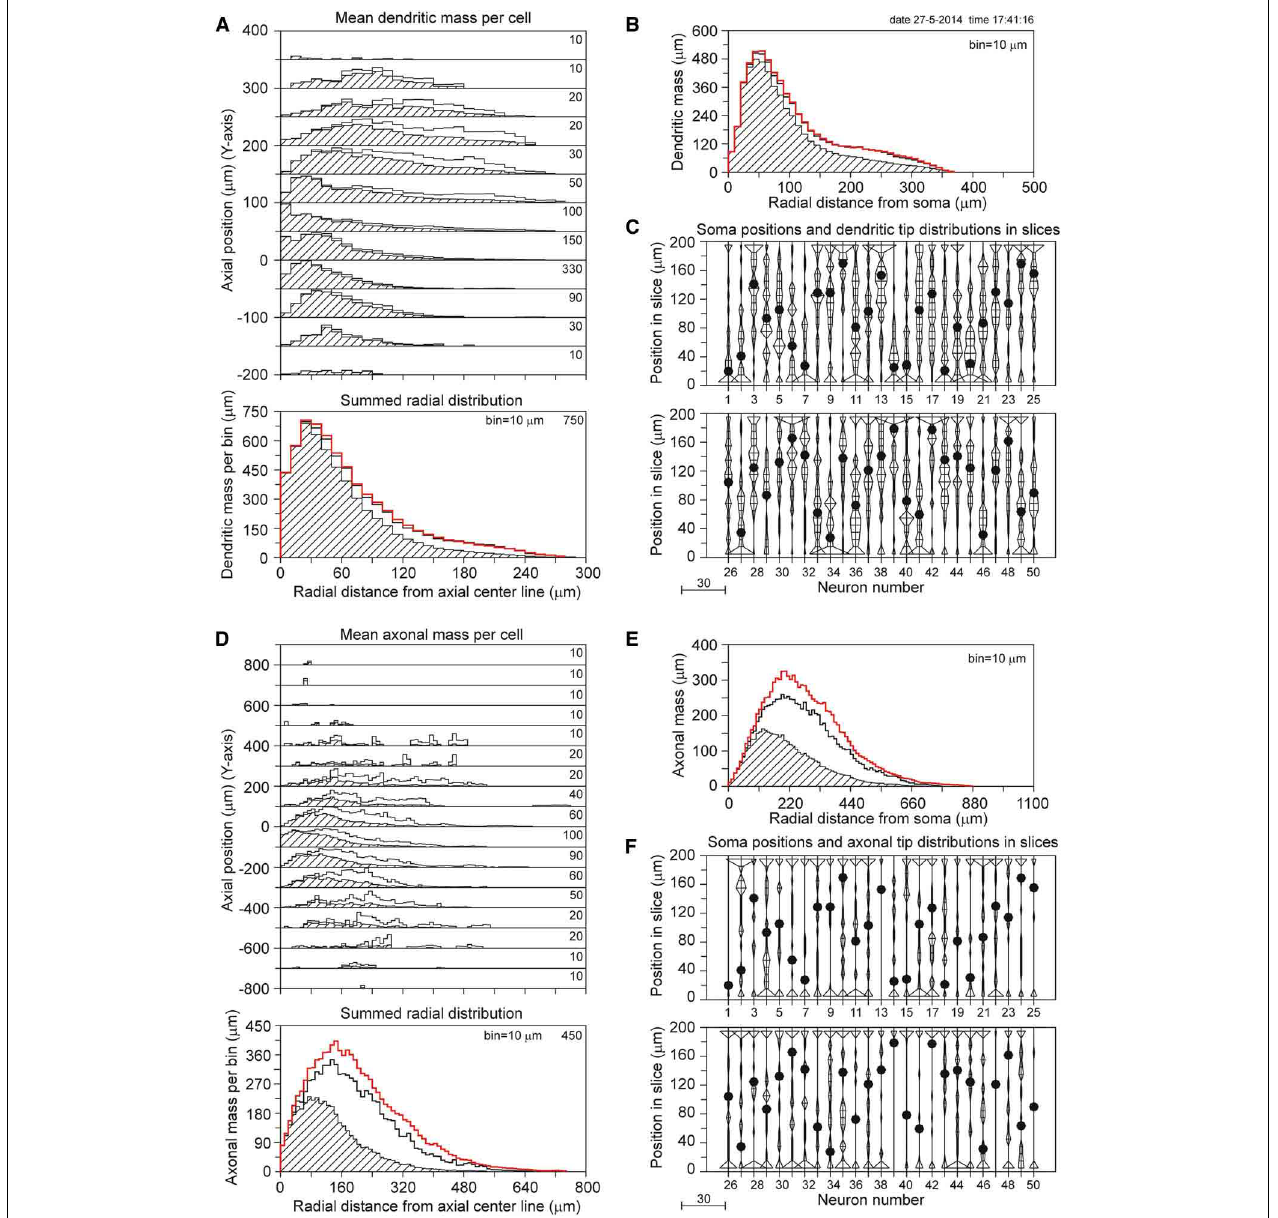
FIGURE 4 | Completion of sliced NETMORPH neurons with a slice thickness of 200 µ m. Orphan branches were not included in the completion procedure. (A) Axial-radial distribution of mean dendritic mass per neuron. The dashed distributions show the mass as obtained within the slice, while the solid black curves show the mass distributions after completion. The axial axis (Y-axis) is binned with bins of 50 μ m, containing their respective radial distributions, which are scaled according to the numbers in the upper right corner in each bin. Thus the mass distribution at a Y-position of -50 μ m has a maximum mass of 330 μ m per radial bin of 10 μ m. The bottom graph in (A) shows the radial dendritic mass distribution summed over all axial Y-positions. The black curve for the completed mass distribution has a strong overlap with the red curve for the full non-sliced dendrites. (B) Distribution of dendritic mass as a function of the radial distance to the soma (this distribution is similar to a